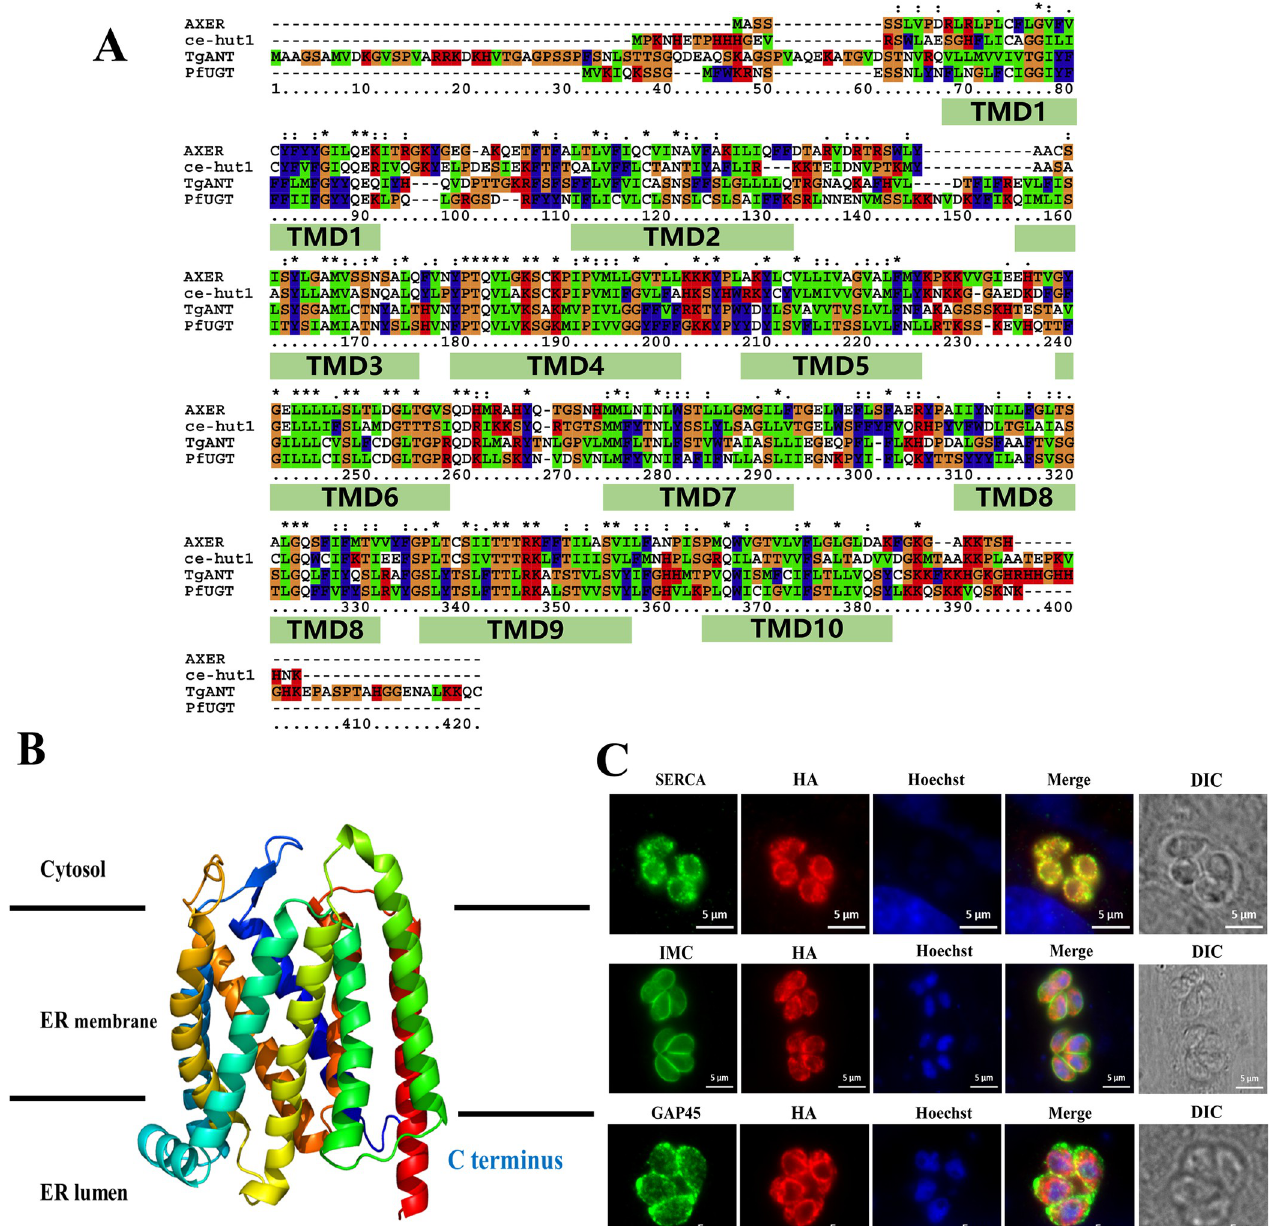
Fig 1. Putative structure and intracellular localization of TgANT. (A) Protein sequences were from NCBI and shown in Gene ID code for Homo sapiens (AXER, Gene ID: 10237), Caenorhabditis elegans (hut-1, Gene ID: 176690), plasmodium (PF3D7-1113300, Gene ID: 810688). The sequences were aligned using ClustalX and TMHMM servers. (B) The hypothetical structural model of TgANT was predicted by the Phyre2 server. The nitrogen terminus and carboxy terminus face the ER lumen, the double lysine motif (-KKQC) is located near the C-terminal end of TgANT. (C) TgANT-HA parasites were subjected to immunostaining using antibodies against the HA tag along with SERCA (sarco/endoplasmic reticulum Ca 2+ -ATPase, ER protein), The result shows that TgANT was complete co-localization with the ER-resident protein SERCA. But not co-localization with IMC (inner membrane complex, inner membrane protein) and GAP45 (gliding-associated protein 45, plasma membrane protein) of T . gondii . Scale bars: 5 μ m.